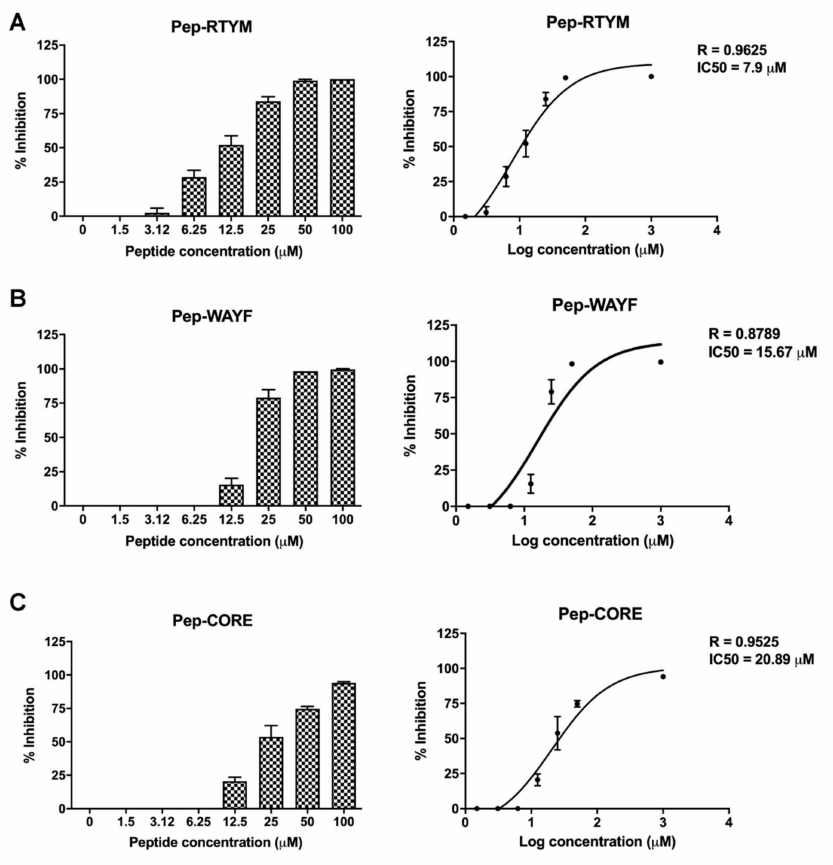
Figure 2. The e ffi ciencies of bioactive peptide inhibitors on dengue virus (DENV) infection. The e ffi ciencies of peptide inhibitors to inhibit DENV2 infection in Vero cells was determined. DENV2 was treated with various concentrations of the peptide inhibitors Pep-RTYM, Pep-WAYF, or Pep-CORE prior to virus infection. Reduction of focus forming units was determined, and the IC50 value for Pep-RTYM ( A ), Pep-WAYF ( B ), and Pep-CORE ( C ) was determined by non-linear regression